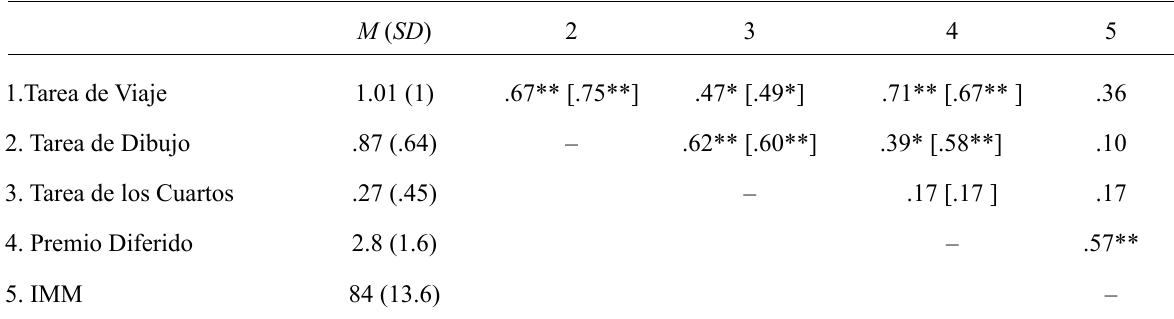
Medias, Desviaciones Típicas (SD) y Correlaciones entre las Tareas Experimentales e Índice de Madurez